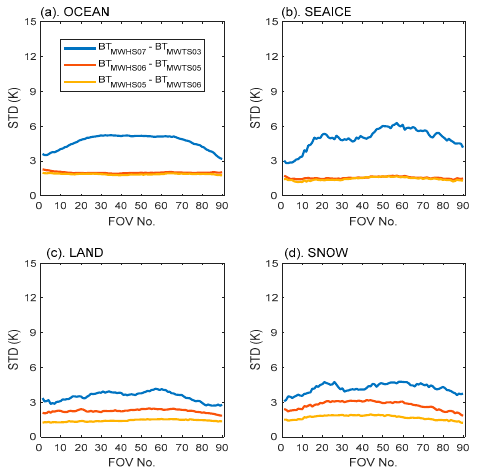
Figure 5. Same as Figure 4 except for the standard deviation. The subfigures represent the situa ‐ tions over ( a ) ocean; ( b ) sea ice; ( c ) land and ( d ) snow. According to Equations (1) and (2), an angular ‐ dependent correction of the bright ‐ ness temperature was added, and the final form is shown below as: CESI (cid:3036)(cid:3033)(cid:3042)(cid:3049) (cid:3404) 𝑇𝐵 (cid:3009) (cid:3398) (cid:3435)𝑟𝑒𝑔𝑇𝐵 (cid:3009) (cid:3398) 𝑠𝑡𝑑𝑇𝐵 (cid:3036)(cid:3033)(cid:3042)(cid:3049) (cid:3439) (cid:3404) 𝑇𝐵 (cid:3009) (cid:3398) (cid:3435)𝛼 (cid:3036)(cid:3033)(cid:3042)(cid:3049) 𝑇𝐵 (cid:3021) (cid:3397) 𝛽 (cid:3036)(cid:3033)(cid:3042)(cid:3049) (cid:3398) 𝑠𝑡𝑑𝑇𝐵 (cid:3036)(cid:3033)(cid:3042)(cid:3049) (cid:3439)